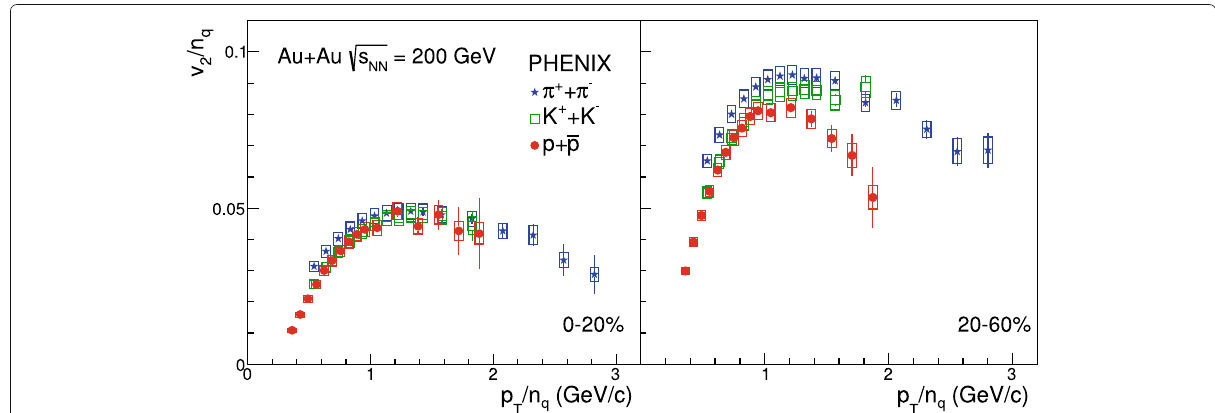
Fig. 7 v 2 / n q of π ± , K ± , and p ( ¯ p ) as a function of the transverse momentum per quark, p T / n q in central (left) and mid-central (right) Au+Au √ collisions at s NN = 200 GeV from the PHENIX experiment [46]